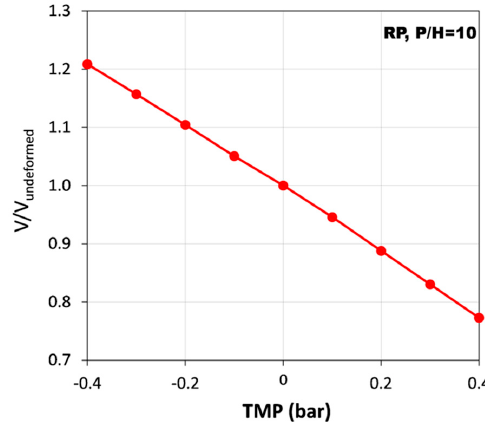
Figure 6. volume (normalized by the undeformed value) as a function of the transmembrane pressure for P / H =10.